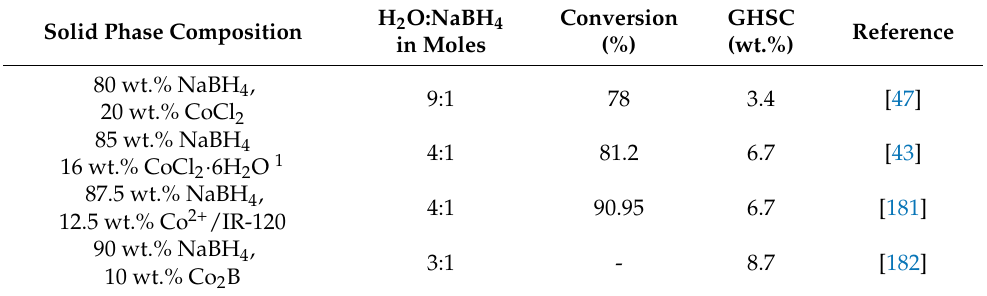
Table 3. Characteristics of H 2 evolution from the solid-phase system based on NaBH 4 . Solid Phase